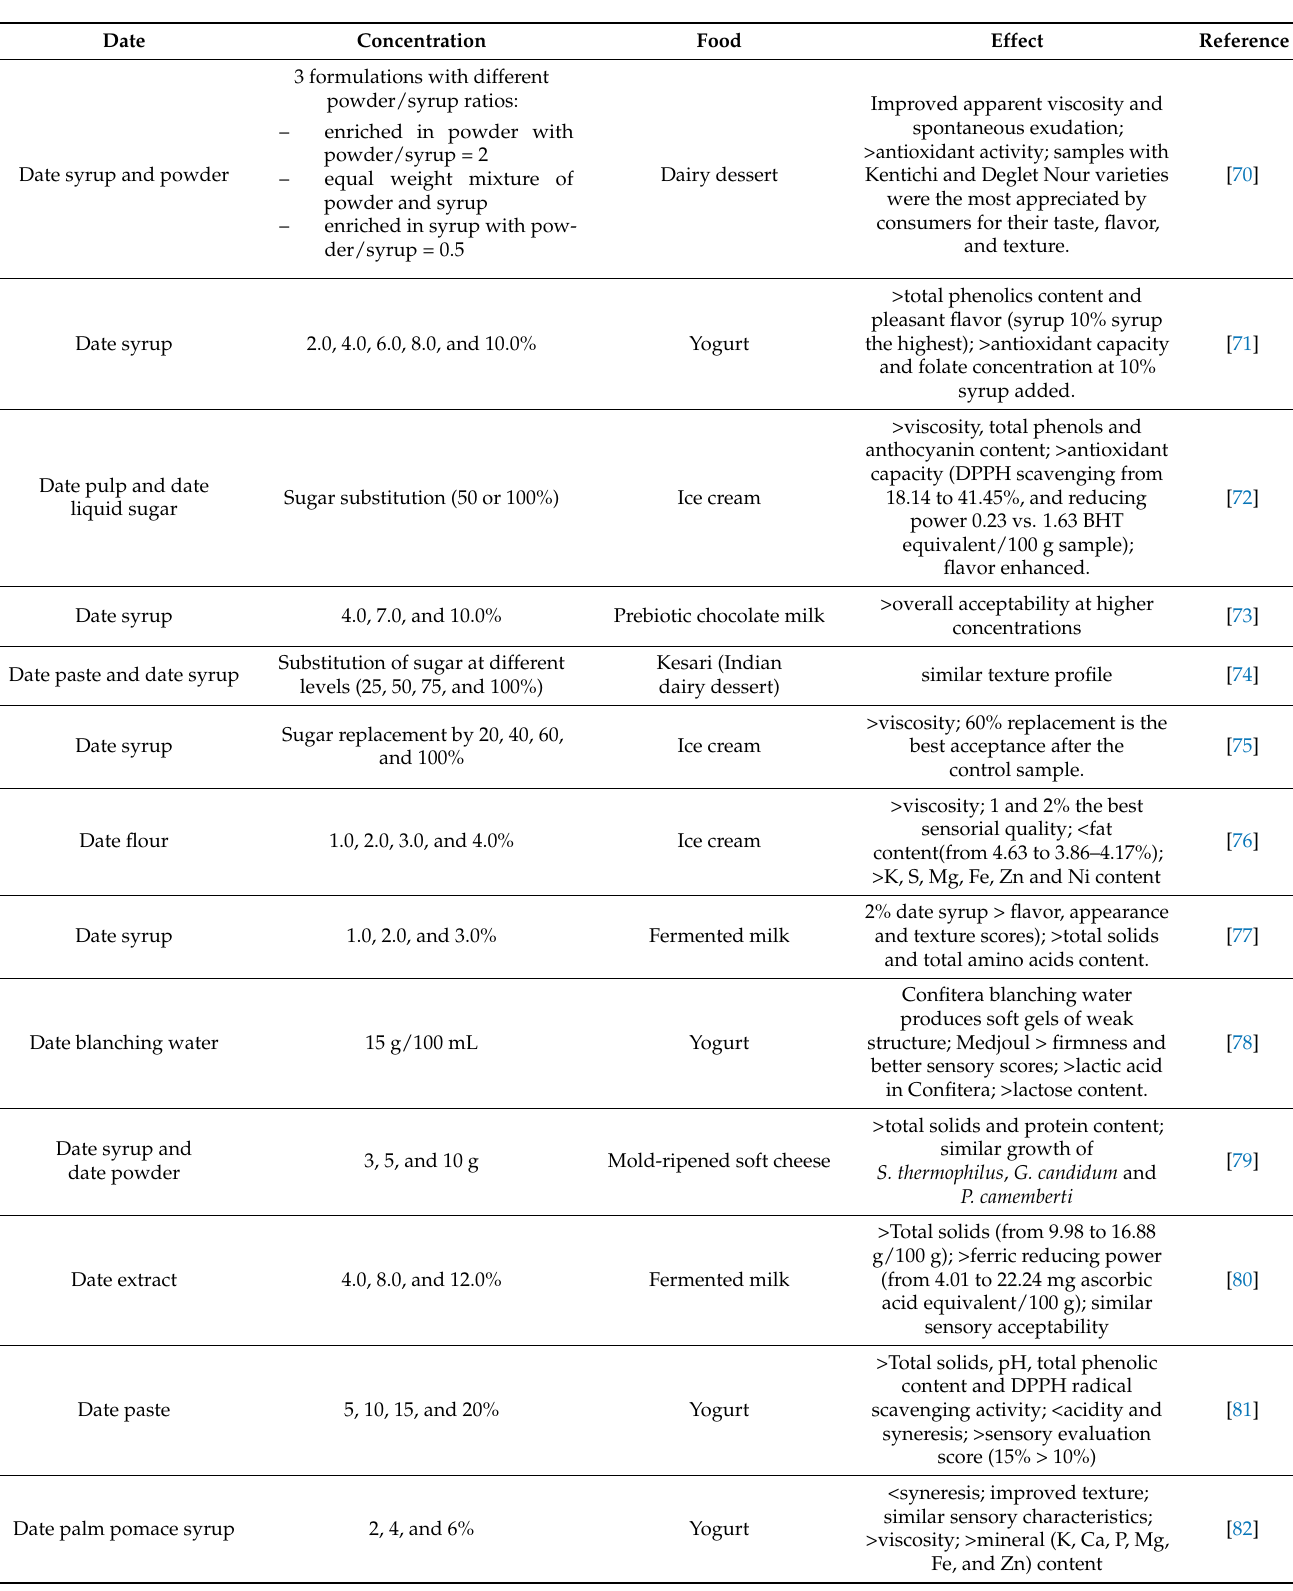
Table 2. Summary of different studies about the application of date fruit and its co-products in dairy